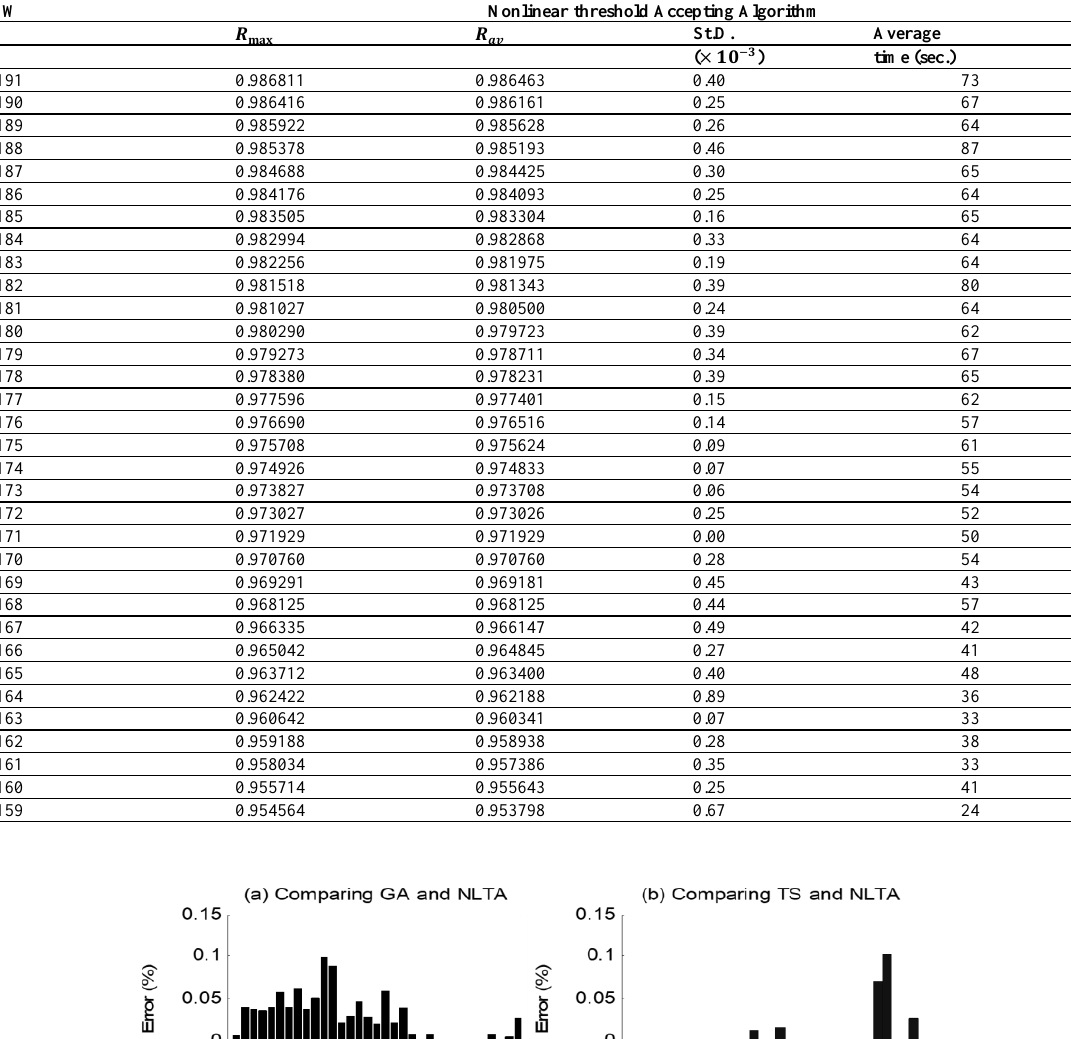
Table 3. Solutions found by NLTA (10 trials).